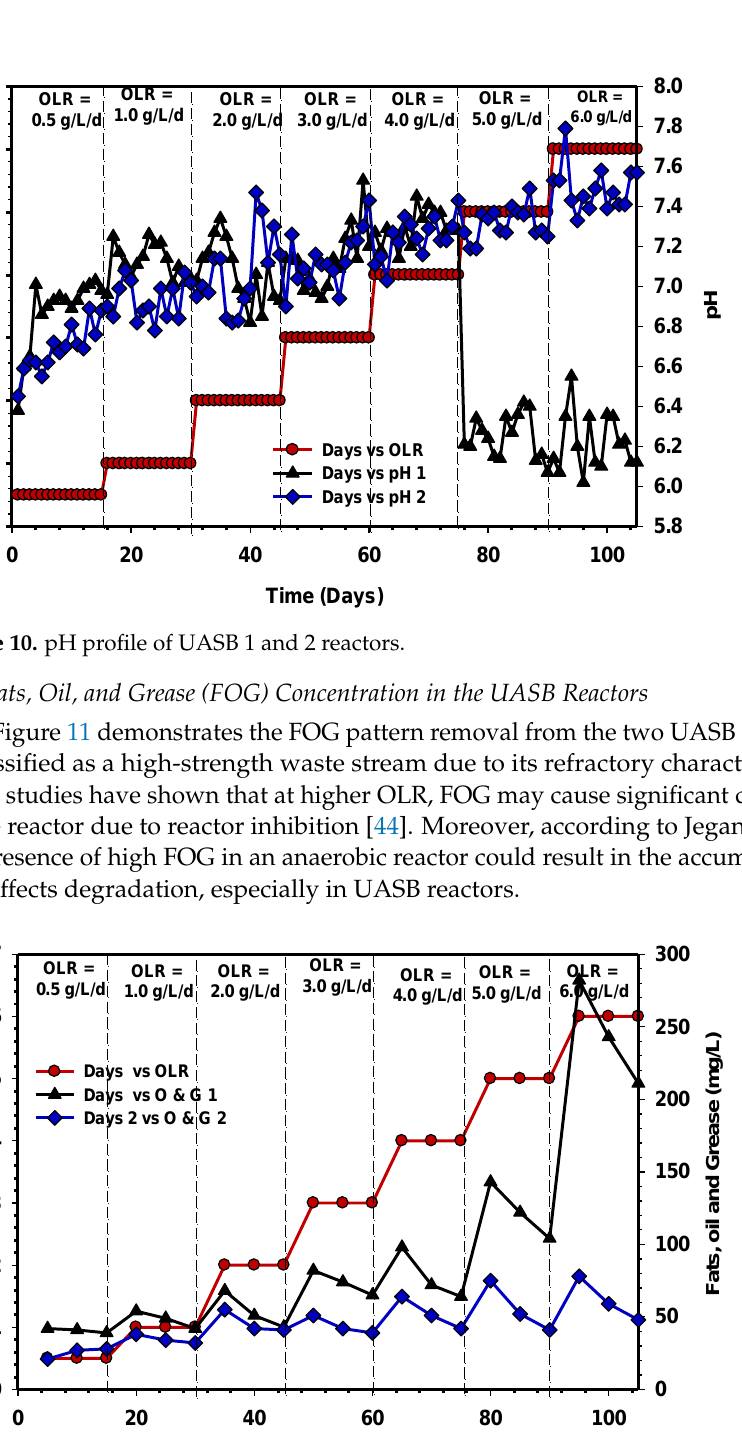
state of AD. Figure 10 demonstrated the pH profile of UASB 1 and 2 at different OLRs.